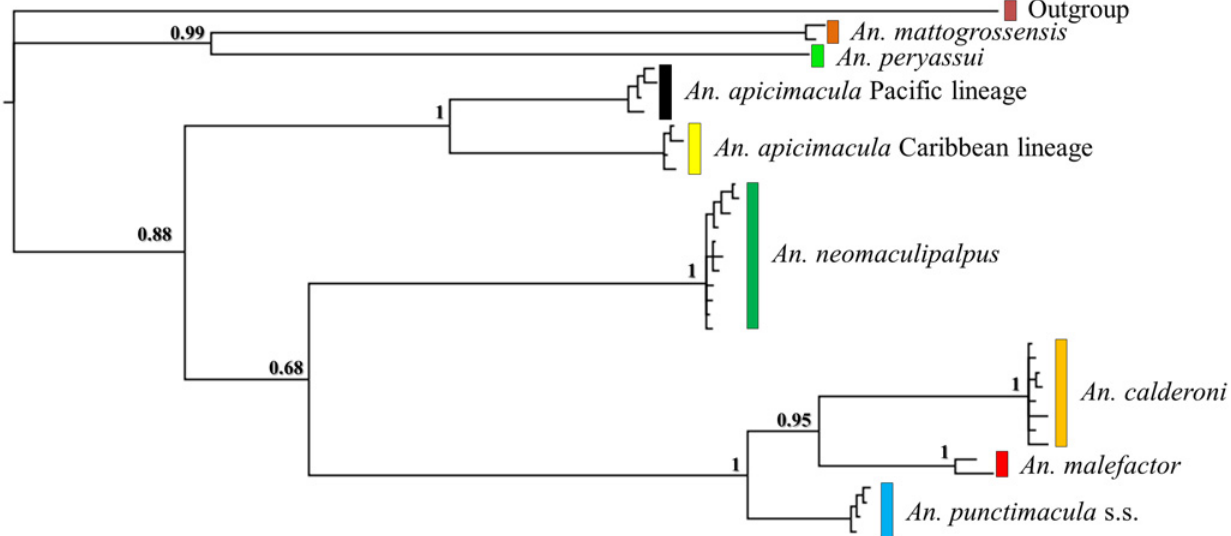
Fig 4. Bayesian topology of the concatenated COI and ITS2 datasets. Numbers on each branch represent posterior probabilities. Anopheles pseudopunctipennis was the